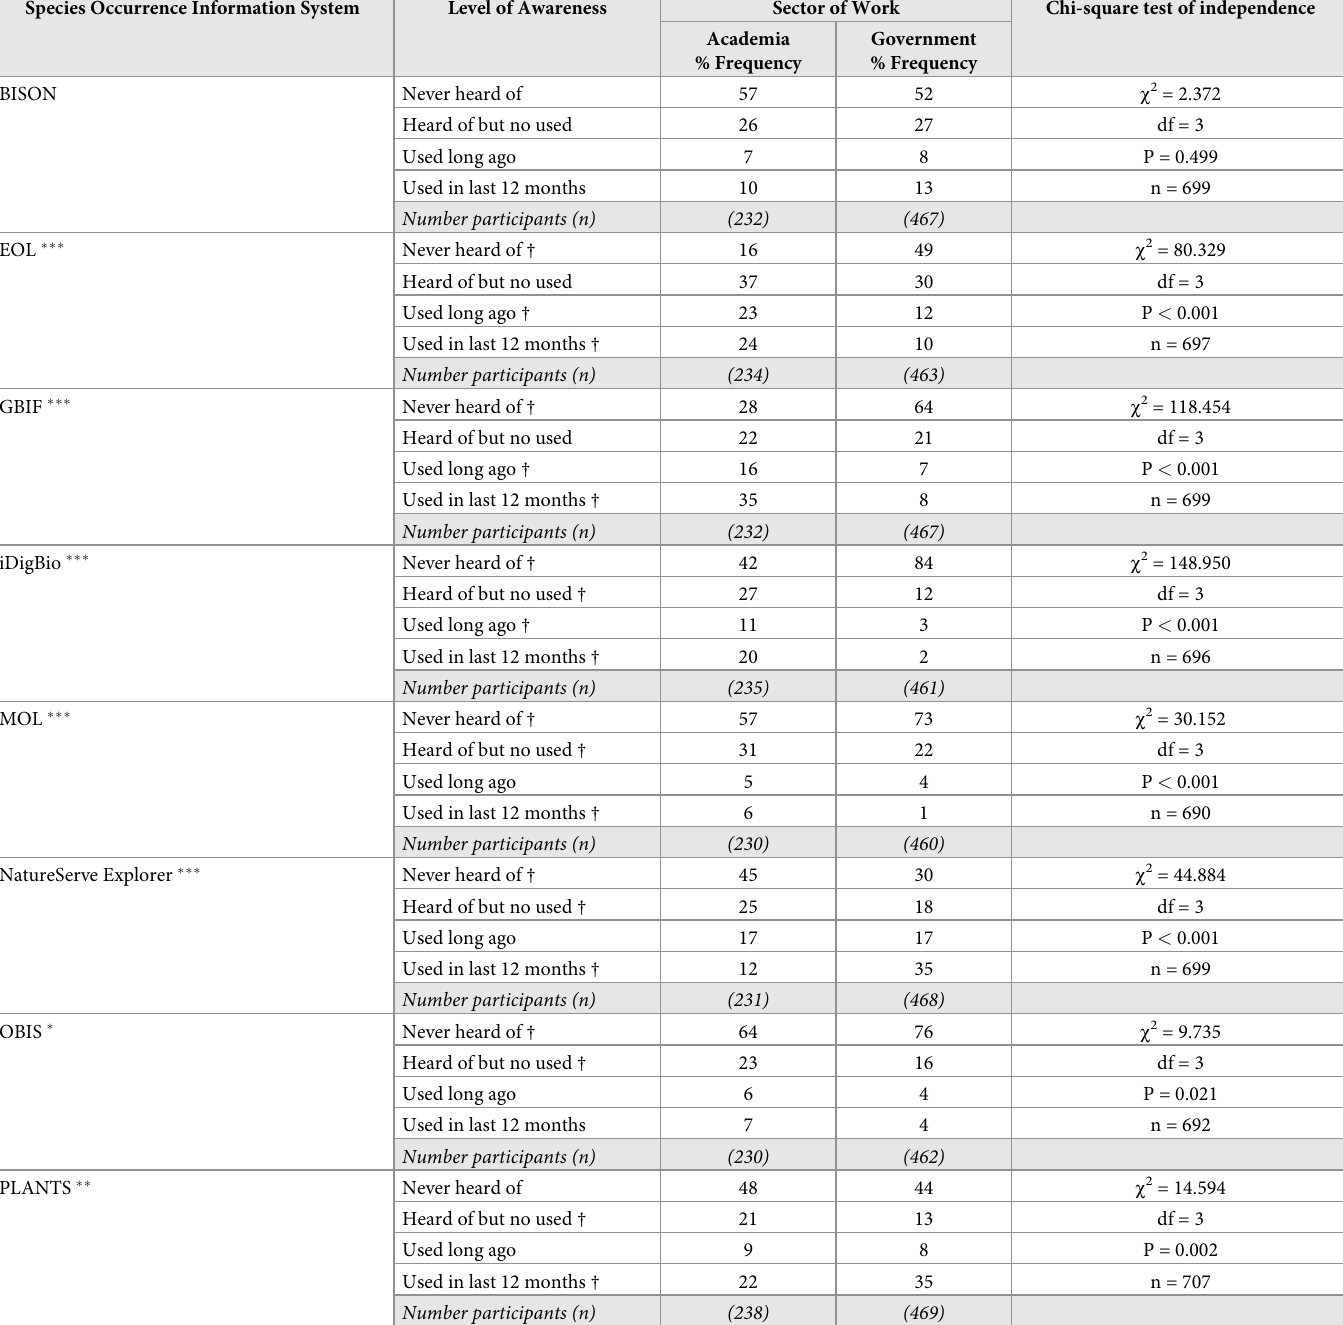
Table 16. Level of awareness of specific web-based species occurrence information